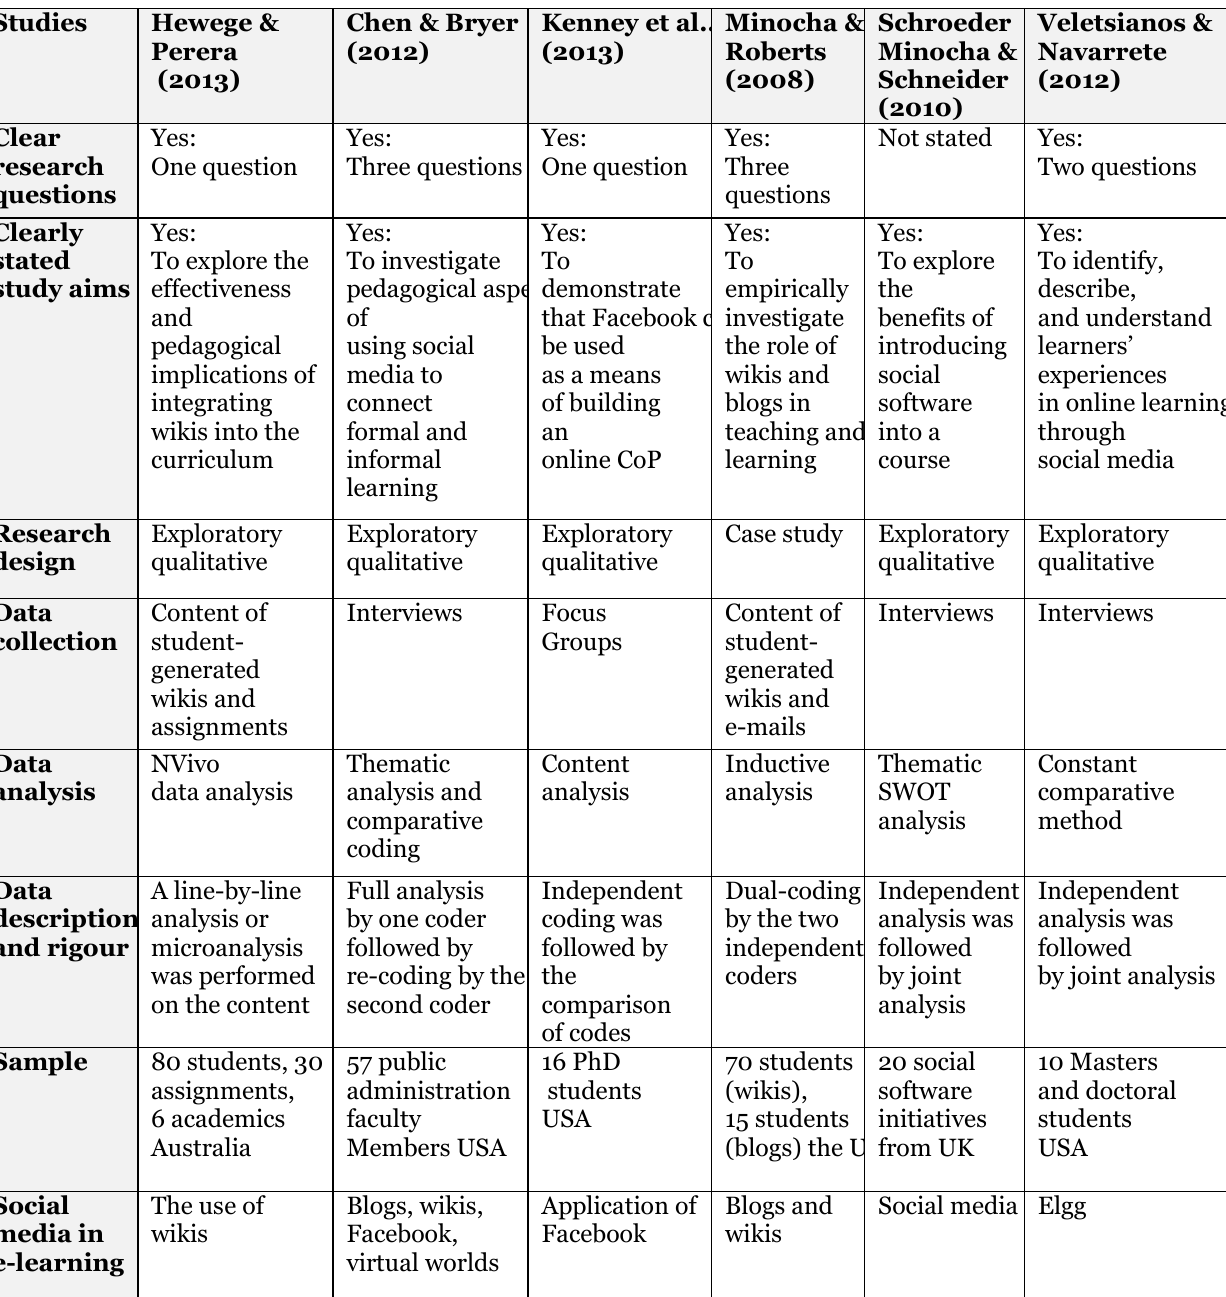
Table 3 Summary of Methodological Aspects in the Different Data